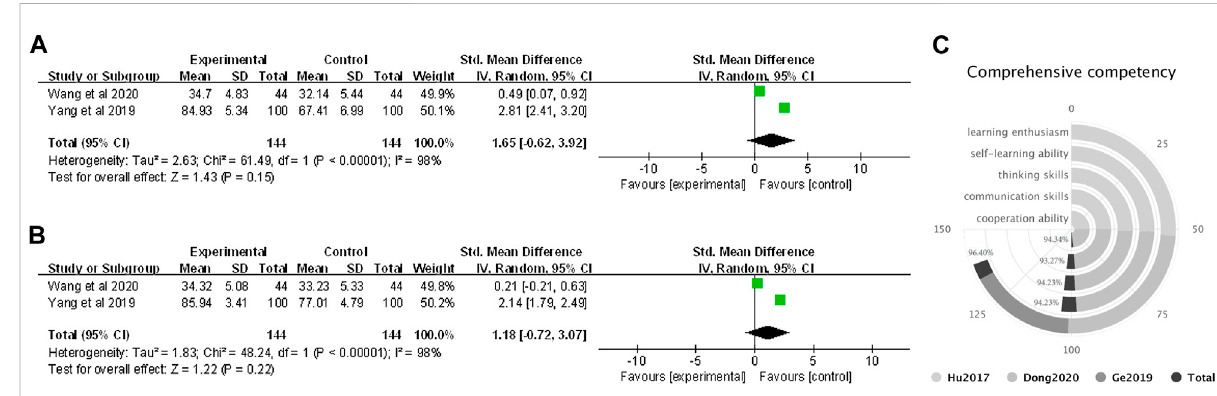
FIGURE 5 Forest plot for effectiveness of FC versus LBL in improving students ’ comprehensive competency of (A) learning motivation; (B) self-study ability; and narrative analysis of (C) learning enthusiasm, self-learning ability, thinking and communication skills, and cooperation ability.